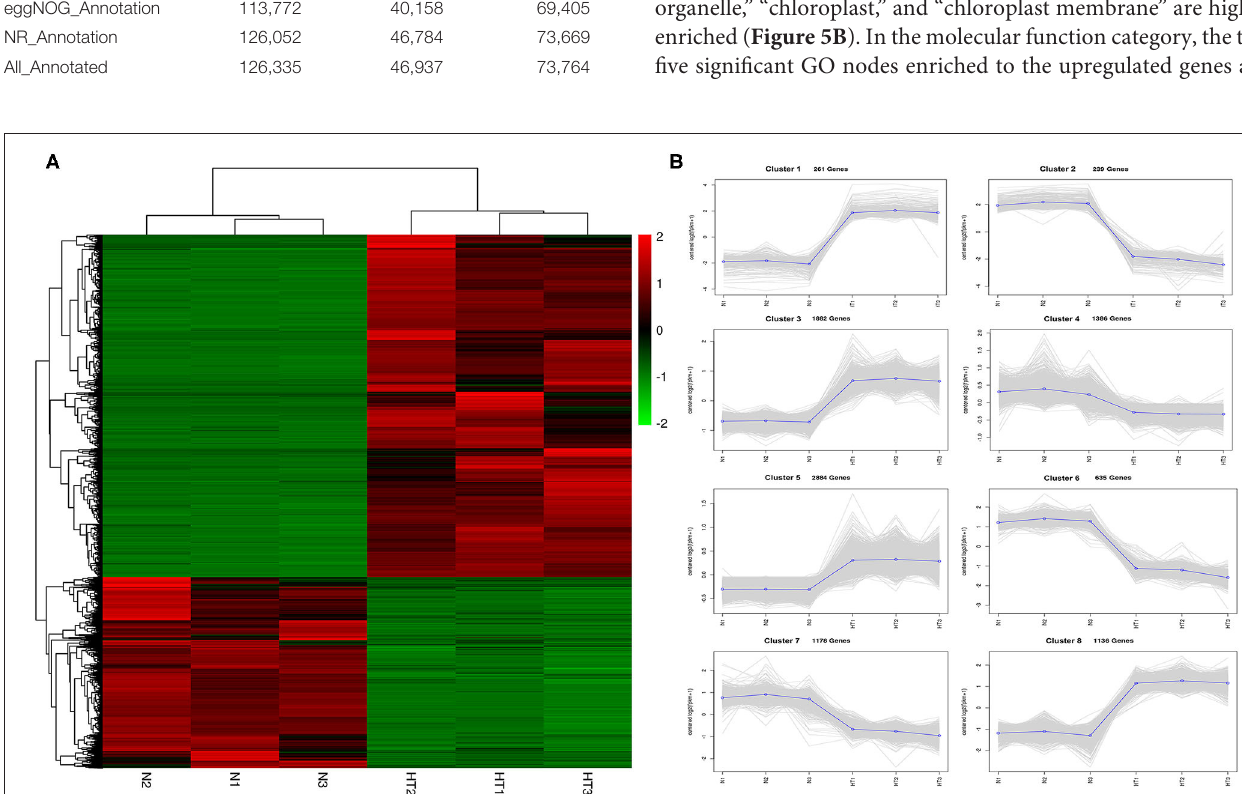
FIGURE 3 | Gene expression profiles from Normal and HT-ms anthers. (A) Heat map diagrams representation of gene expression fold changes (FCs) triggered by the Normal and HT-ms anthers. The colors green, black, and red indicates low, medium, and high expression patterns of genes, respectively. (B) K-mean clustering of the DEGs in eight clusters between the Normal and HT-ms anthers. Thin gray lines represent the expression levels of individual genes. Thick blue lines represent the average expression level of genes in the cluster. The number of genes in each cluster is indicated.